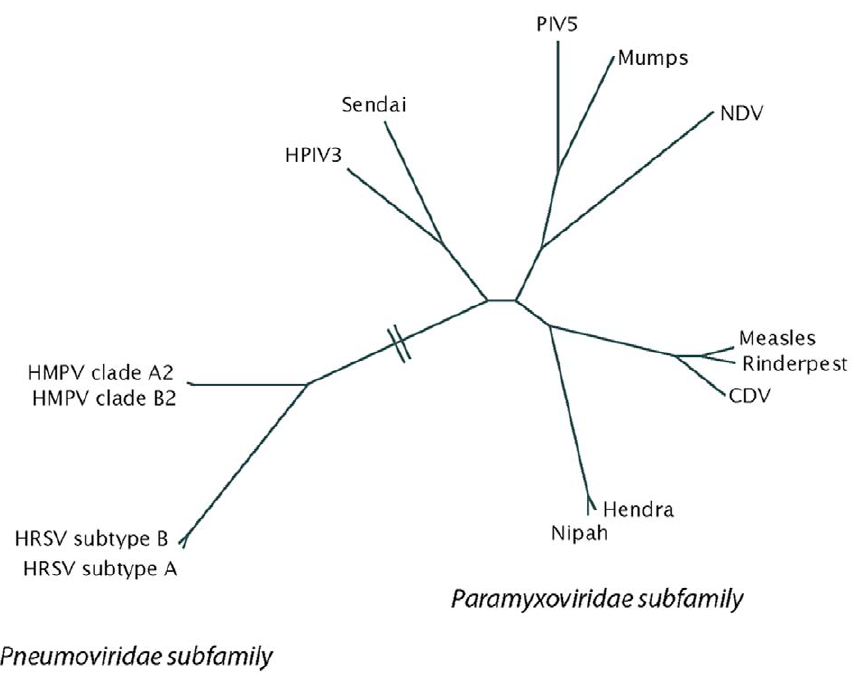
Figure 1. A phylogenetic tree of the paramyxovirus family, built using fusion protein sequence comparison. The tree was generated from a PROMALS multiple sequence alignment using PROTDIST and FITCH from the PHYLIP 3.65 software package and displayed using HYPERTREE 1.0.0. CDV, canine distemper virus; HMPV, human metapneumovirus; HPIV3, human parainfluenza virus 3; HRSV, human respiratory syncytial virus; NDV, Newcastle disease virus; PIV5, parainfluenza virus